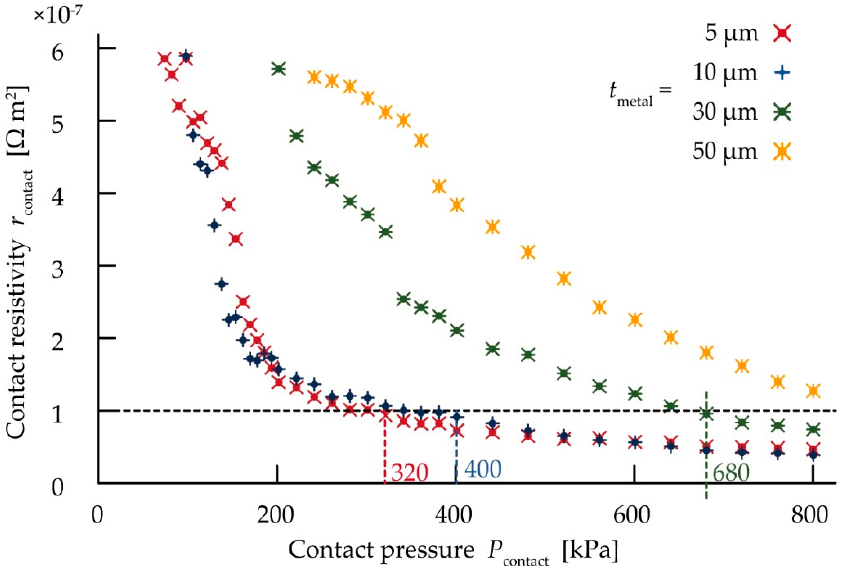
Figure 5. Relationship between contact pressure and contact resistivity with various copper layer thicknesses. The number of trials in each thickness was five.